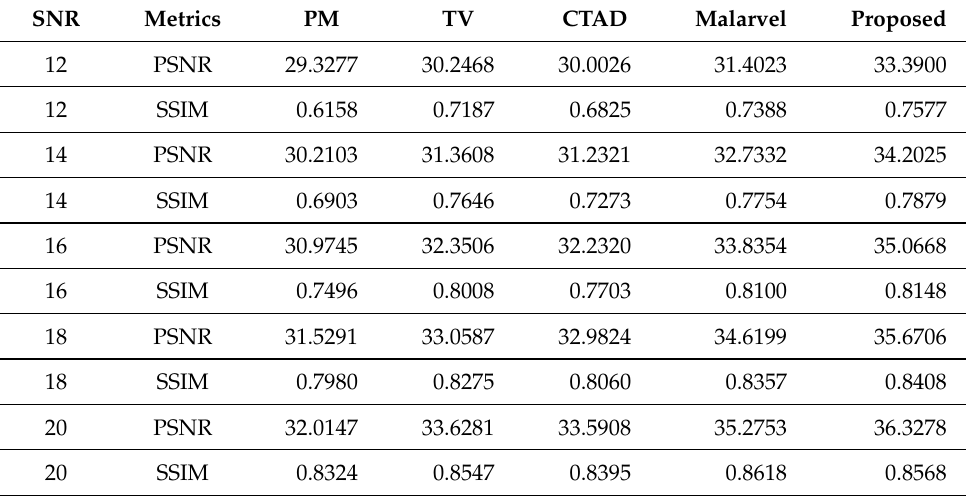
Table 6. Plane image experiment results